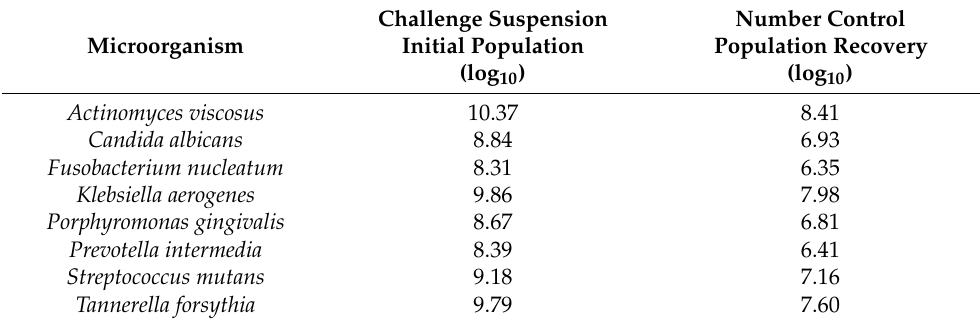
Table 3. Challenge suspensions initial population (log 10 ) and numbers control population recovery (log 10 ) for the microorganisms used in the time-kill kinetic